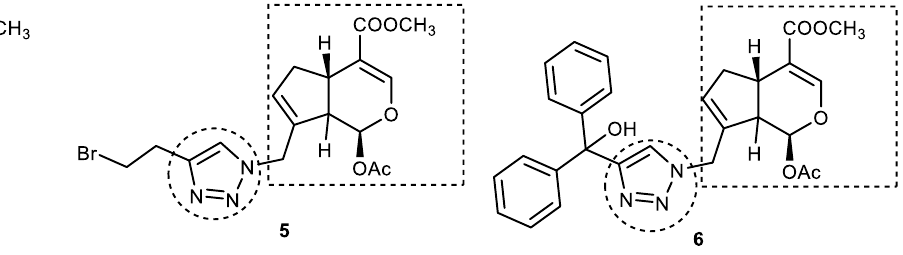
Figure 9. Chemical structures of genipin and genipin – 1,2,3-triazole hybrids.